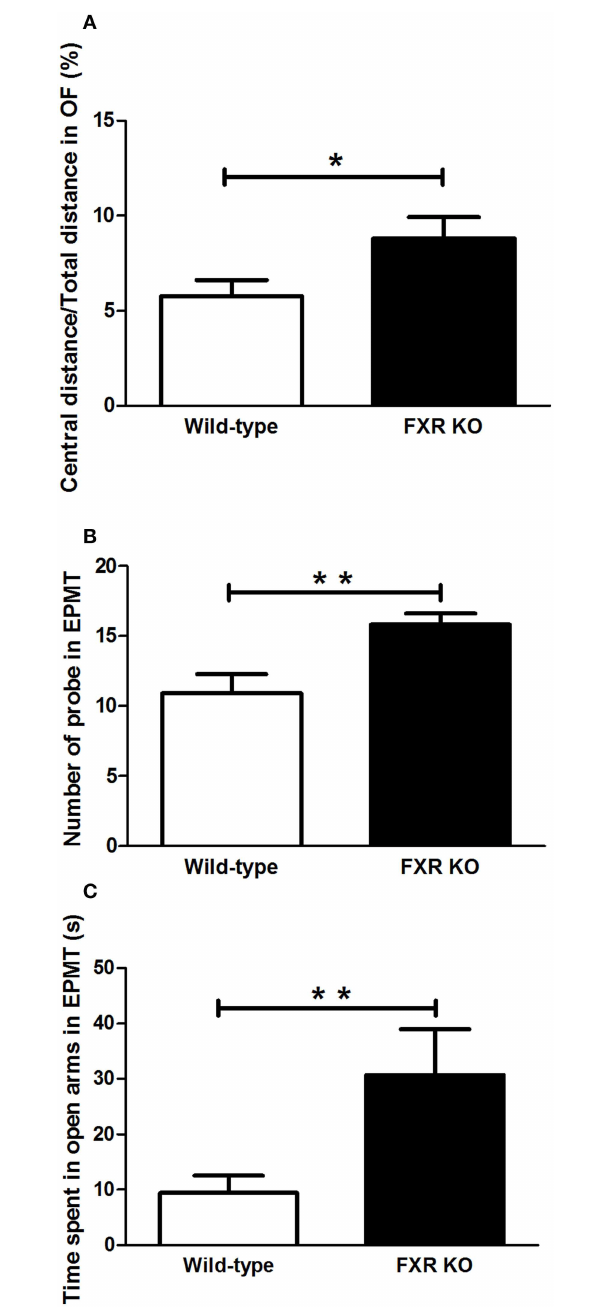
FIGURE 3 | FXR KO mice had low levels of anxiety-related behavior. In comparison with wild-type controls, FXR KO mice had high ratio of central distance/total distance in the OFT (A) . Moreover, the KO mice had a greater tendency to explore (B) and to stay in the open arm in the EPMT (C) . N = 12 /group; * p < 0 . 05 ; ** p < 0.01.